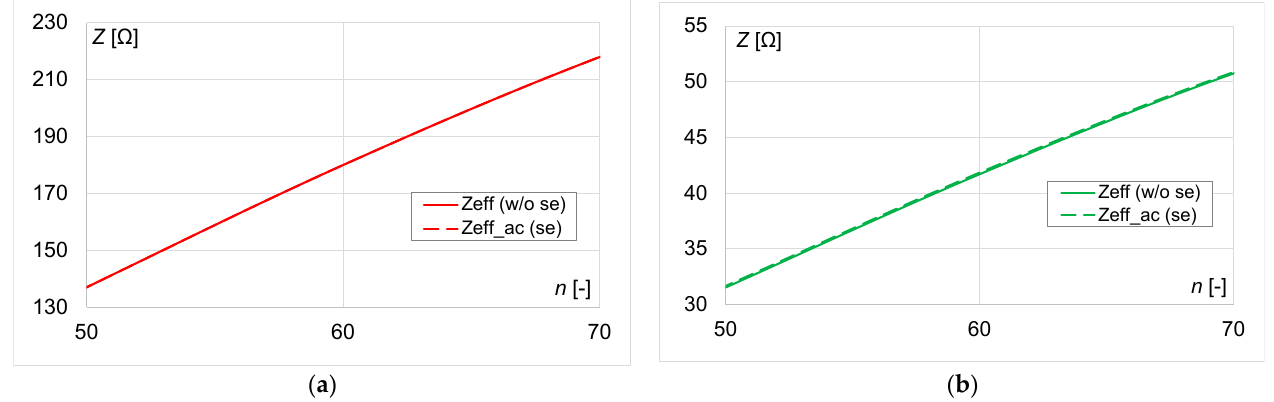
Figure 5. Load impedance for the cases with and without skin effect at 1 MHz for the small coil at